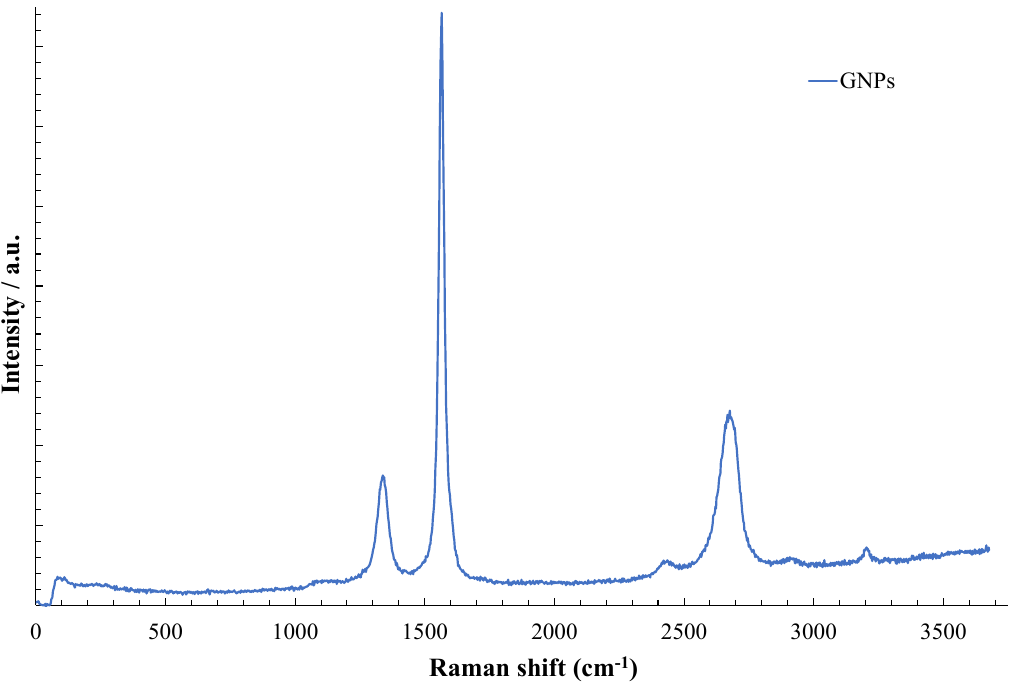
Figure 2. Rama spectrum of graphene nanoplatelets .